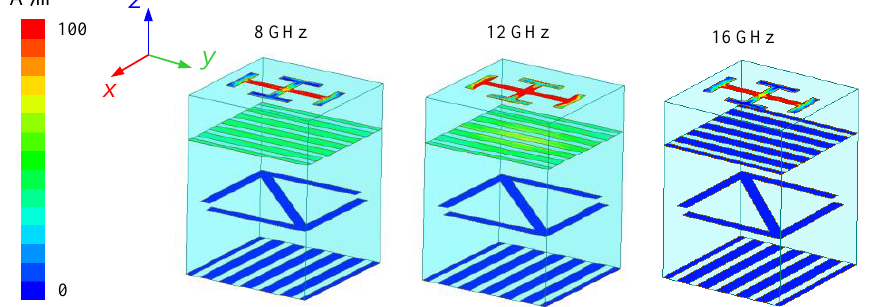
Figure 7. Surface current distribution of element when y -polarized wave incident.